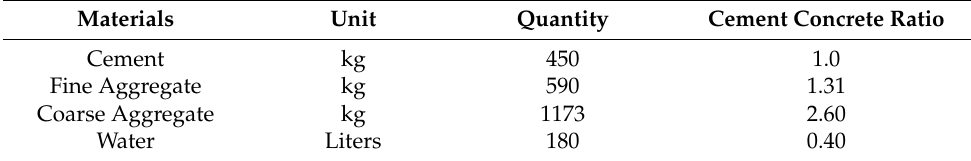
Table 5. Mix of M40 grade concrete for cement concrete road